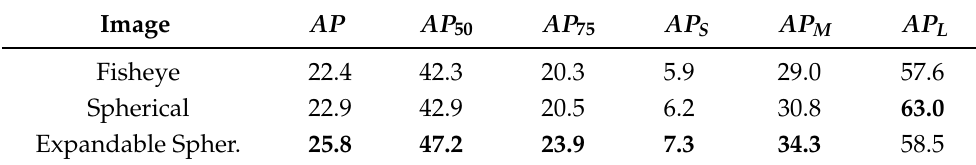
Figure 12. Detection results: ( a ) Synthetic fisheye image; ( b ) Spherical-projected image; ( c ) Expand- able Spherical-projected image from Fisheye-CityScape. Table 6. Accuracy of different projections of SCat model on the Fisheye-CityScape.